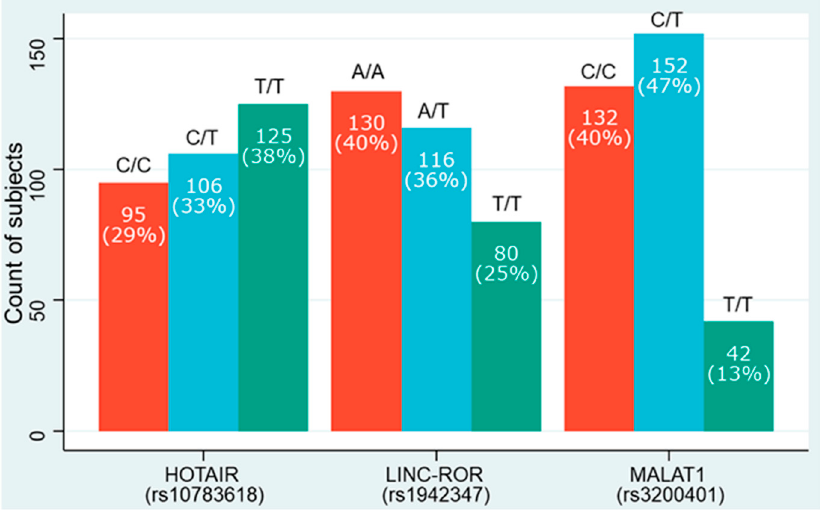
Figure 1. Genotype frequency of lncRNA genotypes in the study population. Data are presented as count (percentage). Table 2. Genotype and allele frequencies of HOTAIR , LINC-ROR , and MALAT1 polymorphisms.